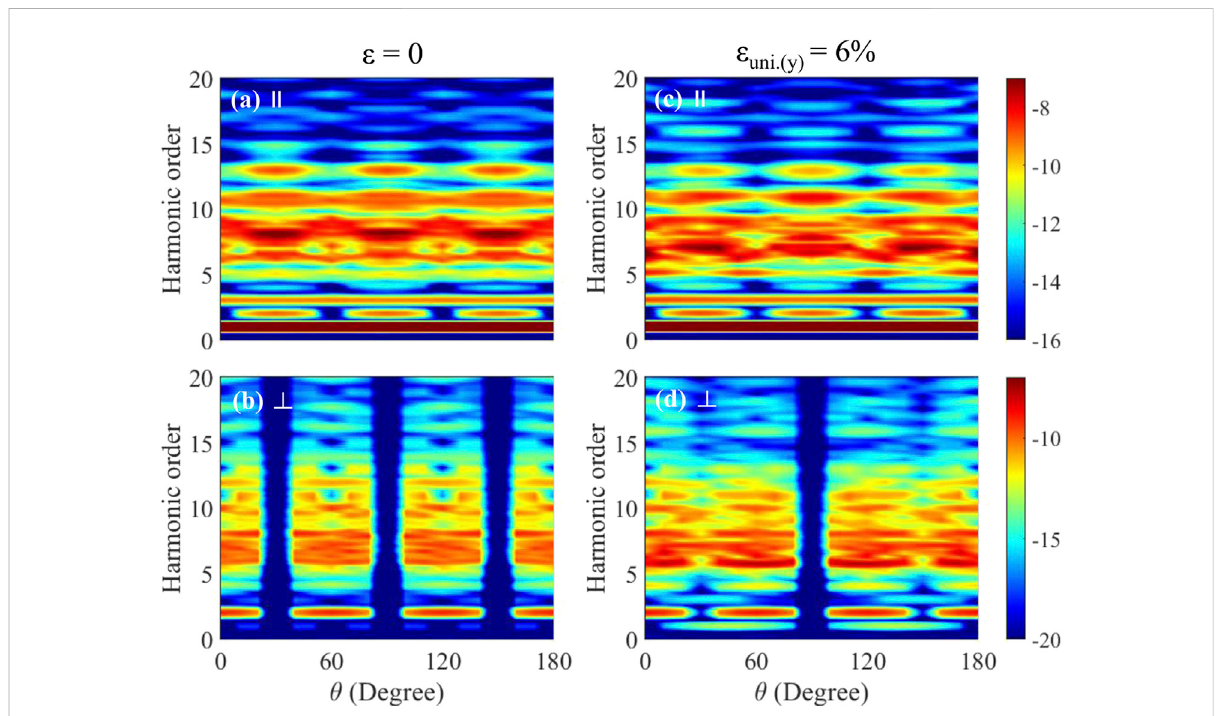
FIGURE 6 Logarithmic colormap for the polarization-dependent harmonic intensity in the monolayer hBN. Left panels: the HHG in the strain-free monolayer hBN for the (A) parallel and (B) the perpendicular components. Right panels: The HHG in the stretching monolayer hBN with ε uni.(y) = 6% for the (C) parallel and (D) the perpendicular components.